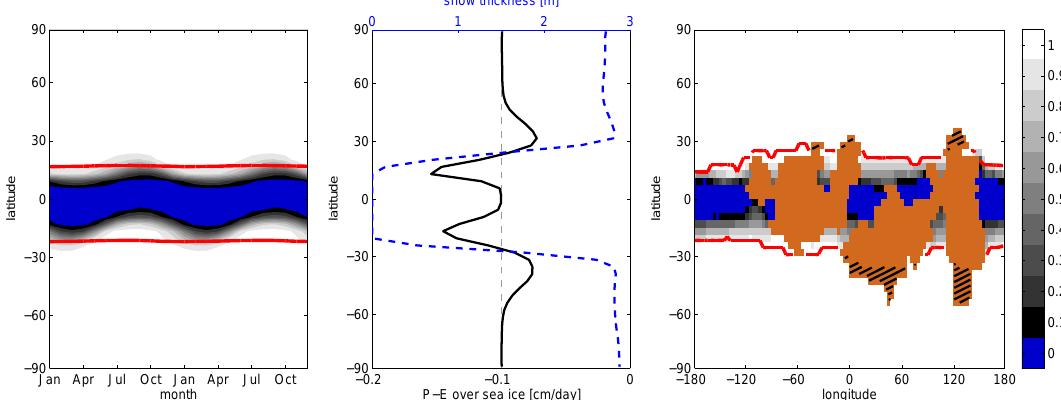
Fig. 9. Simulation with low bare sea-ice albedo, disabled sea-ice dynamics, and 4ppm CO 2 . The simulation equilibrates at 85% sea-ice cover. Left: seasonal cycle of zonal-mean sea-ice fraction. Blue indicates open ocean, white a sea-ice fraction of one (see color bar on the right). The red line separates bare sea ice (equatorward of the red line) from snow-covered sea ice (poleward of the red line). Middle: Annual- mean zonal-mean snow fall onto sea ice minus evaporation over sea ice (black solid) and thickness of snow on sea ice (blue dashed). Right: annual-mean sea-ice fraction with the same color coding as in the left figure. The red line separates bare sea ice (equatorward of the red line) from snow-covered sea ice (poleward of the red line). Continents are shown in brown. In the hatched continental regions snow accumulation exceeds 1cmyr − 1 .